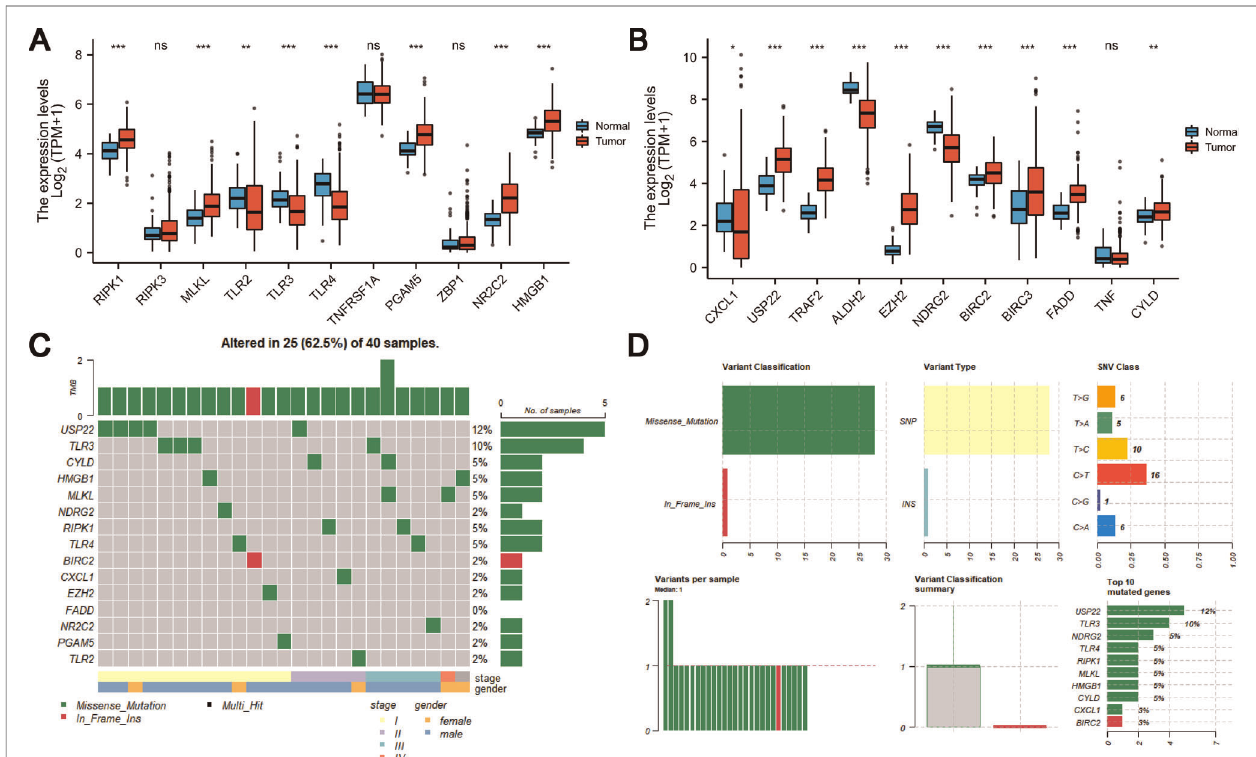
FIGURE 2 | Expression and genetic mutation of necroptosis-related genes in HCC. ( A and B ) Expression of necroptosis-related genes in HCC. ( C and D ) Incidence of necroptosis-related gene mutations and their categorization in